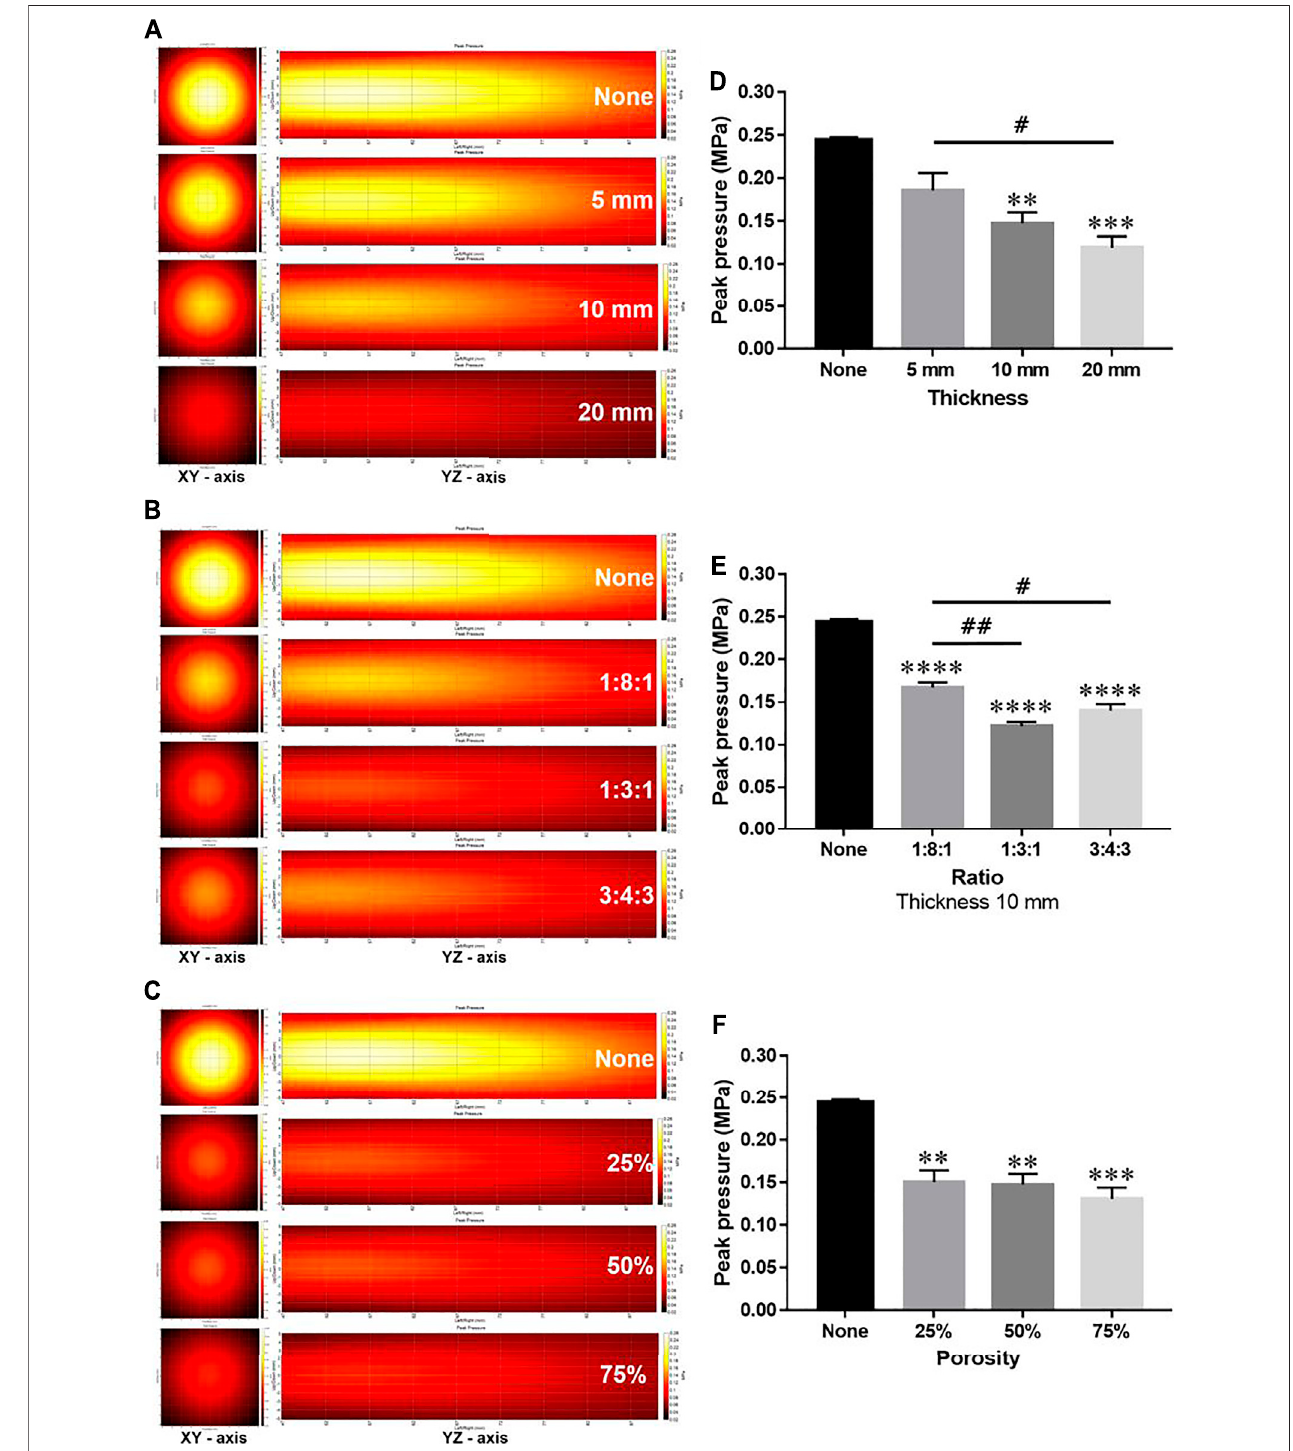
FIGURE 3 | Comparison of ultrasound energy attenuation rates according to skull variables. (A – C) XY-axis and YZ-axis images of the ultrasound beam according tothickness,ratio,andporosityofthephantom. (D – F) Measurementresultsofpeakpressureattenuationofultrasonicenergyaccordingtothickness,ratio,andporosity. Dataareshownasthemean ± standarderrorofthemean(SEM; n (cid:1) 3pergroup,one-wayANOVAwithTukey ’ smultiplecomparisontest).* p < 0.05vs.None.# p < 0.05.